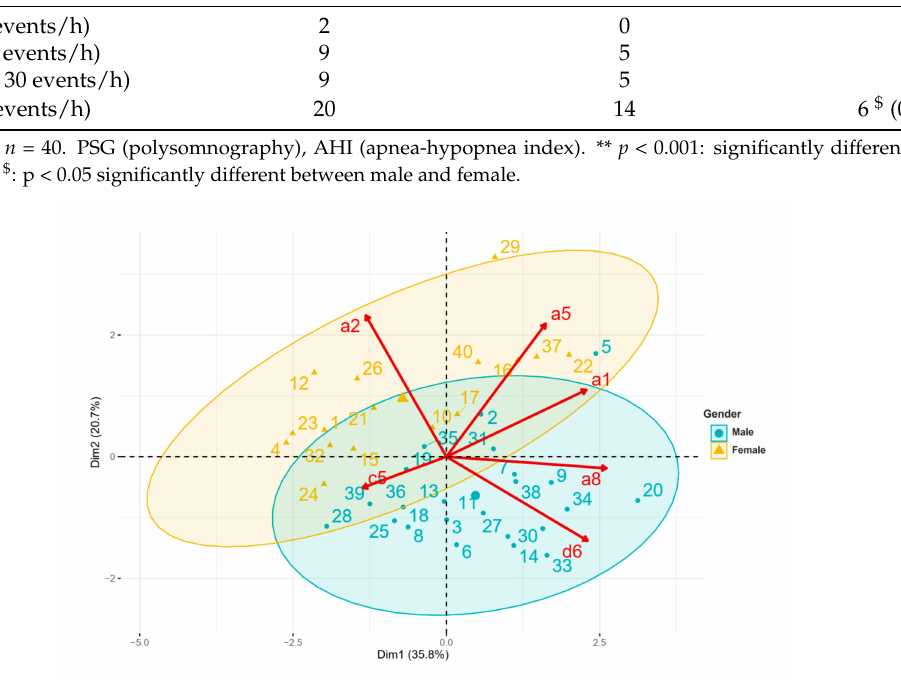
Figure 1. Principal component analysis biplot. Participants with DS are represented from 1 to 40.